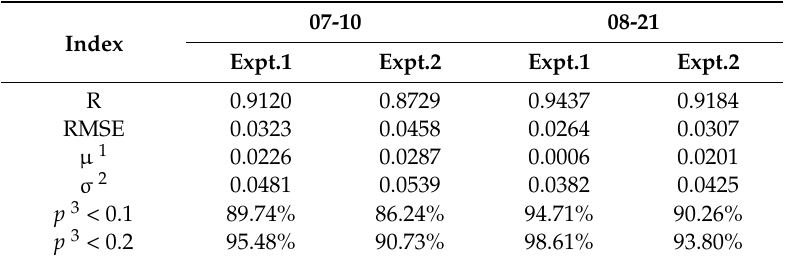
Table 7. NDVI accuracy